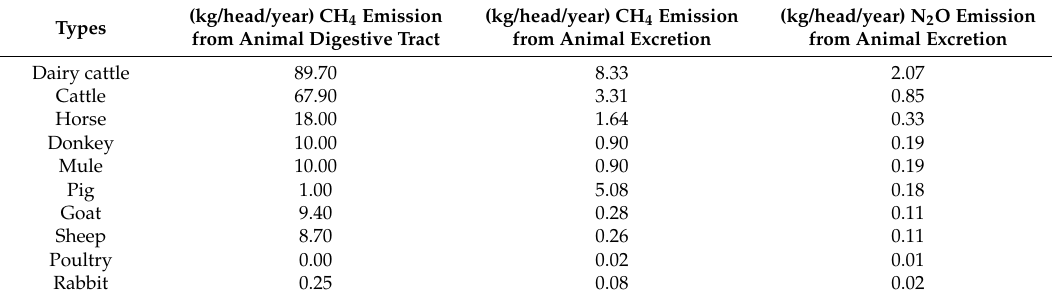
Table 3. Emission coefficients for CH 4 and N 2 O emissions from